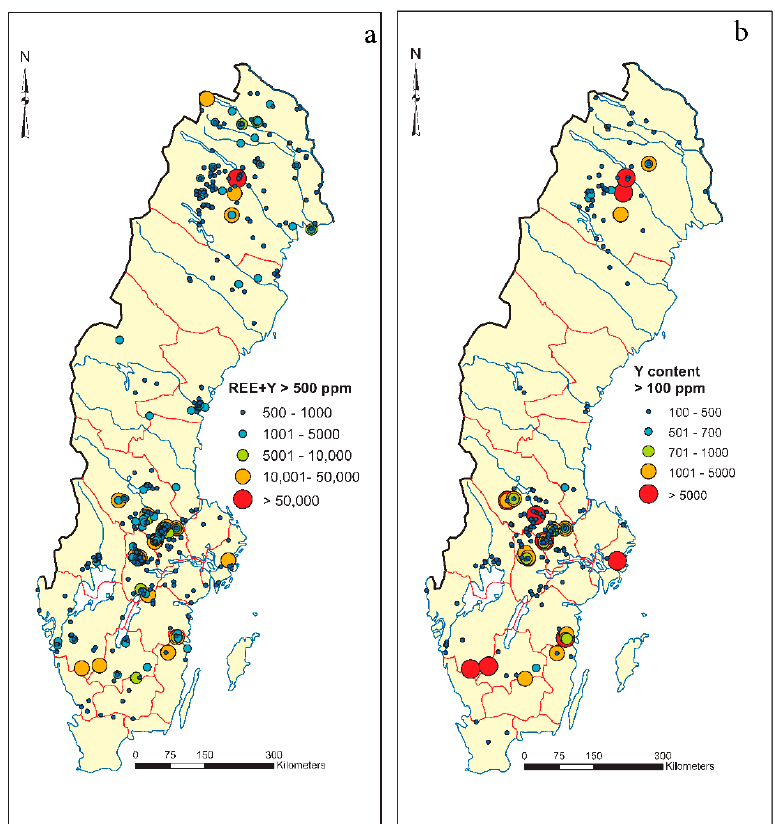
Figure 3. Simplified map of lithogeochemical data in Sweden: ( a ) total REE + Y > 500 ppm and ( b ) Y content > 100 ppm (source of data: lithogeochemical database at the Geological survey of Sweden).